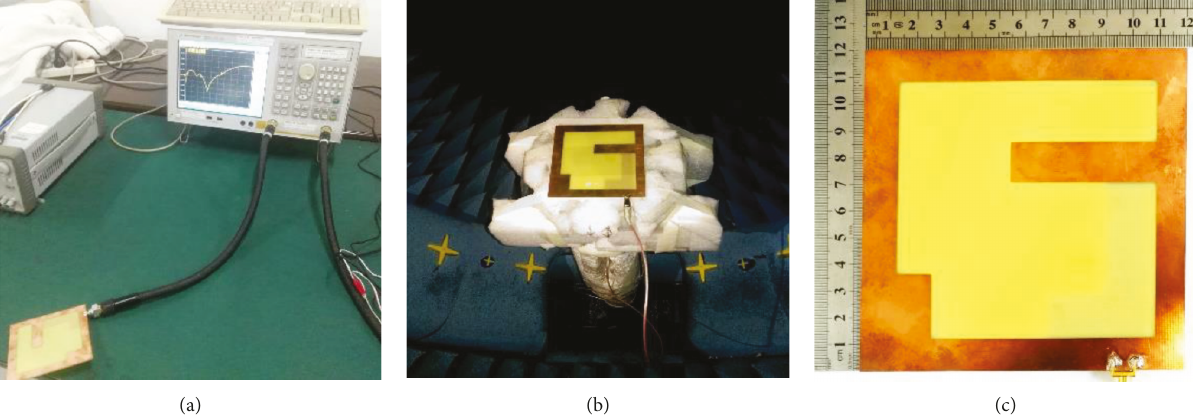
Figure 13: Fabricated antenna experiment using (a) the E5071C VNA and (b) the SATIMO measurement system. (c) Photograph of the proposed